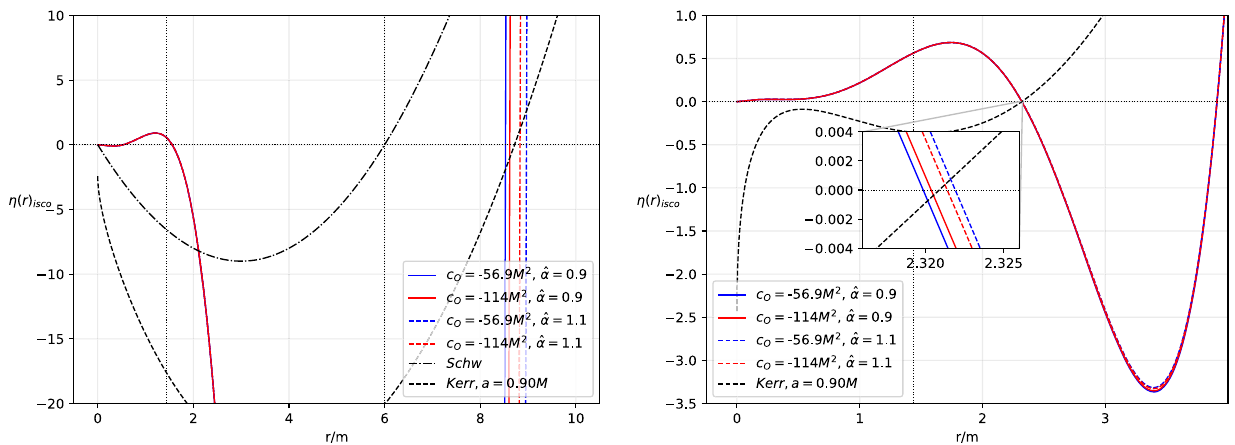
Fig. 7 Location of ISCO radius for counter-rotation of a massive particle (left-panel) and co-rotation of a massive particle (right-panel). We set a = 0 . 90 M in both